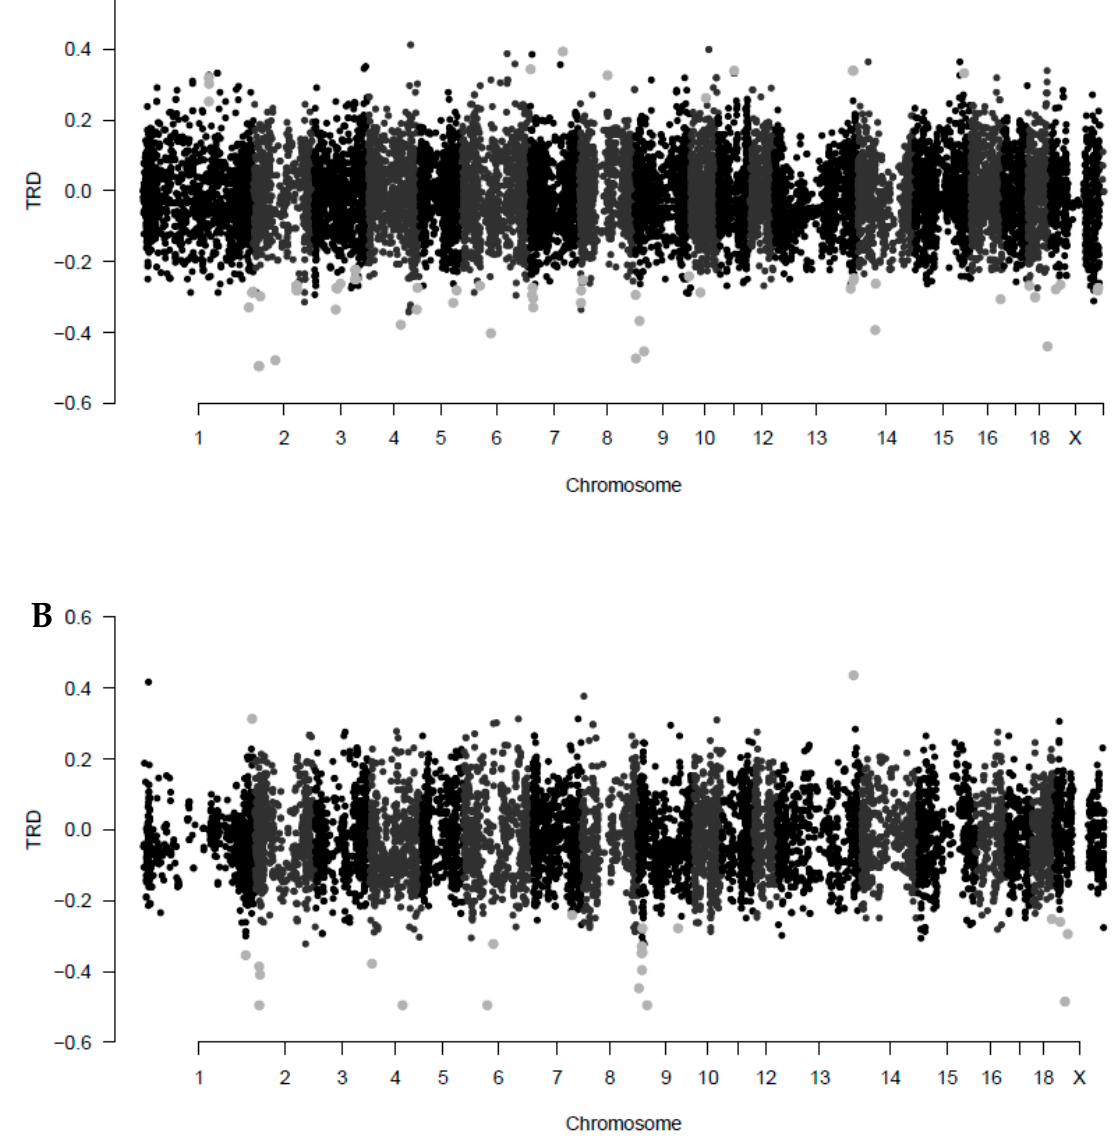
Figure 2. Distribution of maternal transmission ratio distortion (TRD) values in families of Entrepelado ( A ) and Retinto ( B ) varieties across pig chromosomes. Light grey points are significant TRD ( q < 0.05).